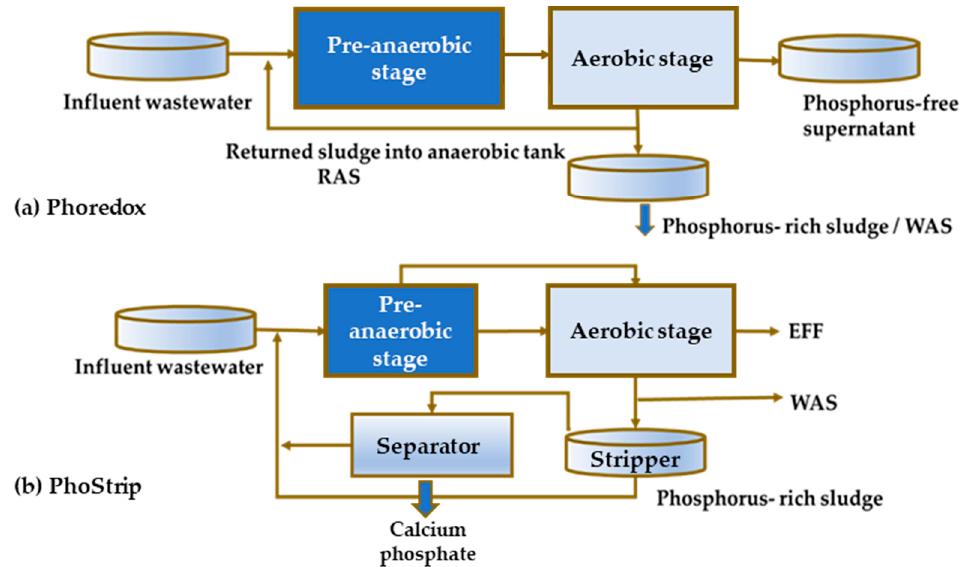
Figure 1. A typical configuration for P removal in the mainstream EBPR (Phoredox process) ( a ), sidestream EBPR (PhoStrip process) ( b ) (abbreviations: EFF—effluent, RAS—recirculated activated sludge, WAS—waste activated sludge).